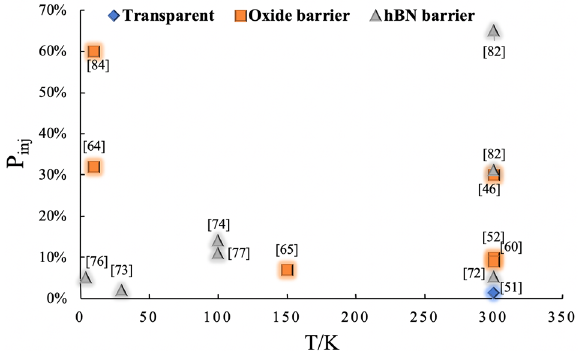
Fig. 2 Development of electrical injection with different tunnel bar‑ riers.